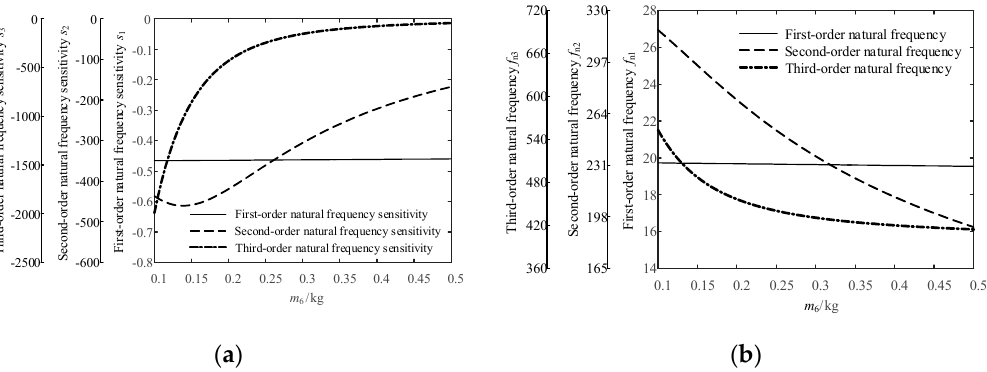
Figure 14. The variation law of the first three natural frequencies and their sensitivities of the jet system